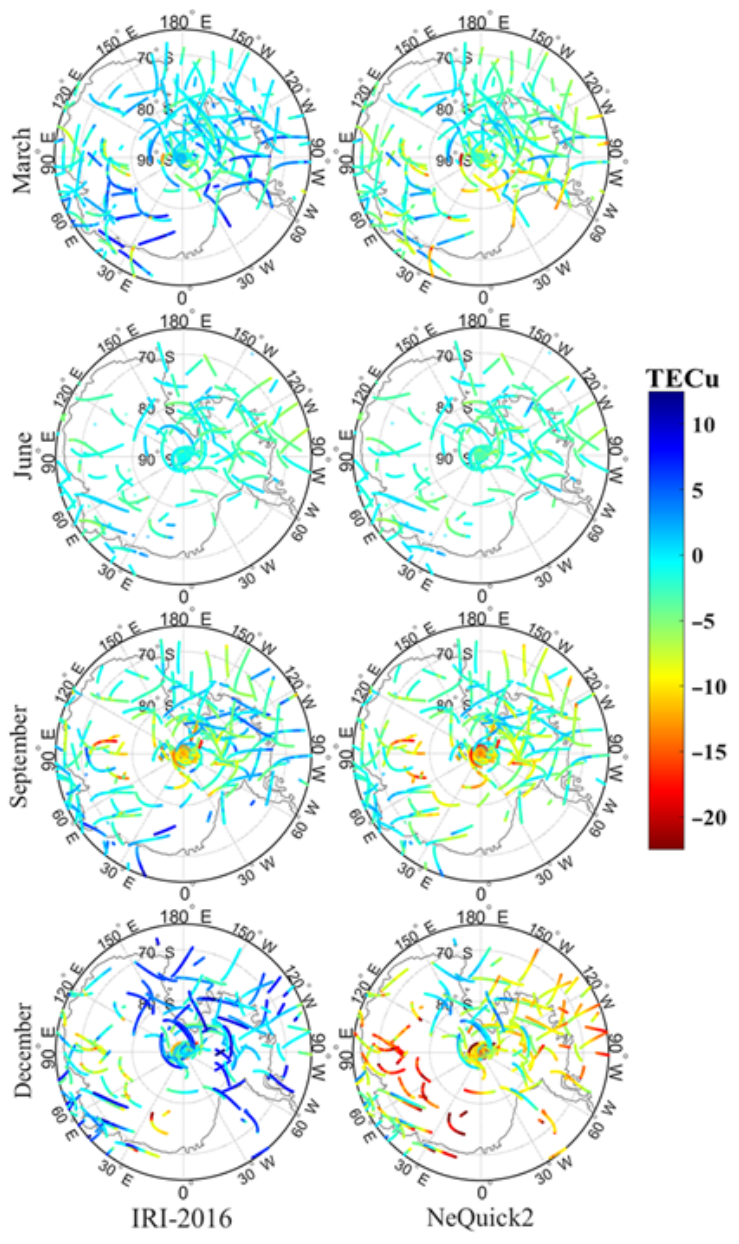
Figure 5. Distribution of difference of STEC (dSTEC) of the International Reference Ionosphere-2016 and NeQuick2 models at 14:00 UT during the experiment period.